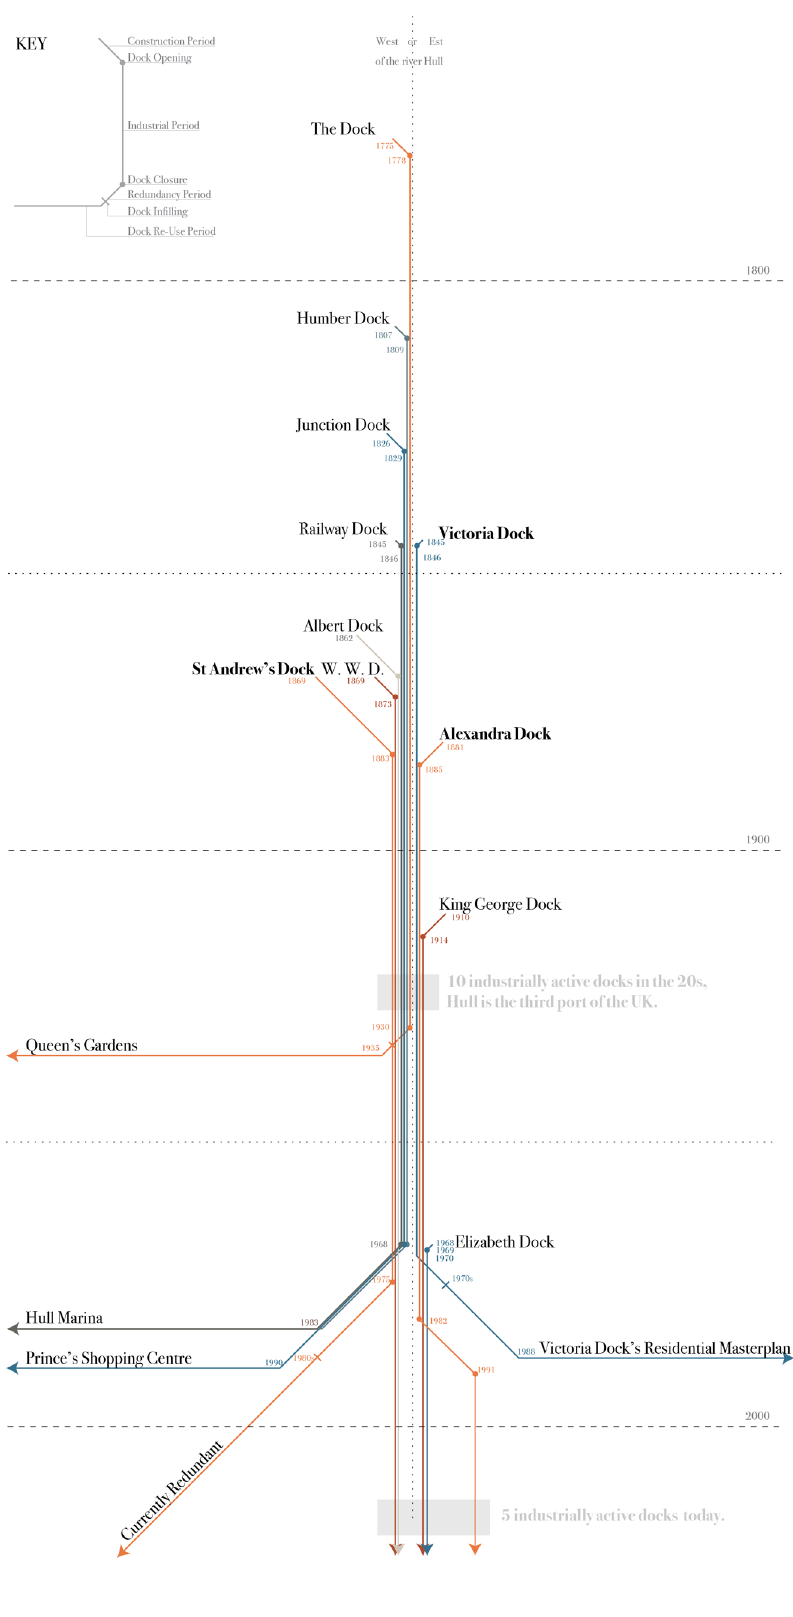
FIG. 2 Spatio-temporal diagram of the evolution of Hull’s docklands, original drawing by author,